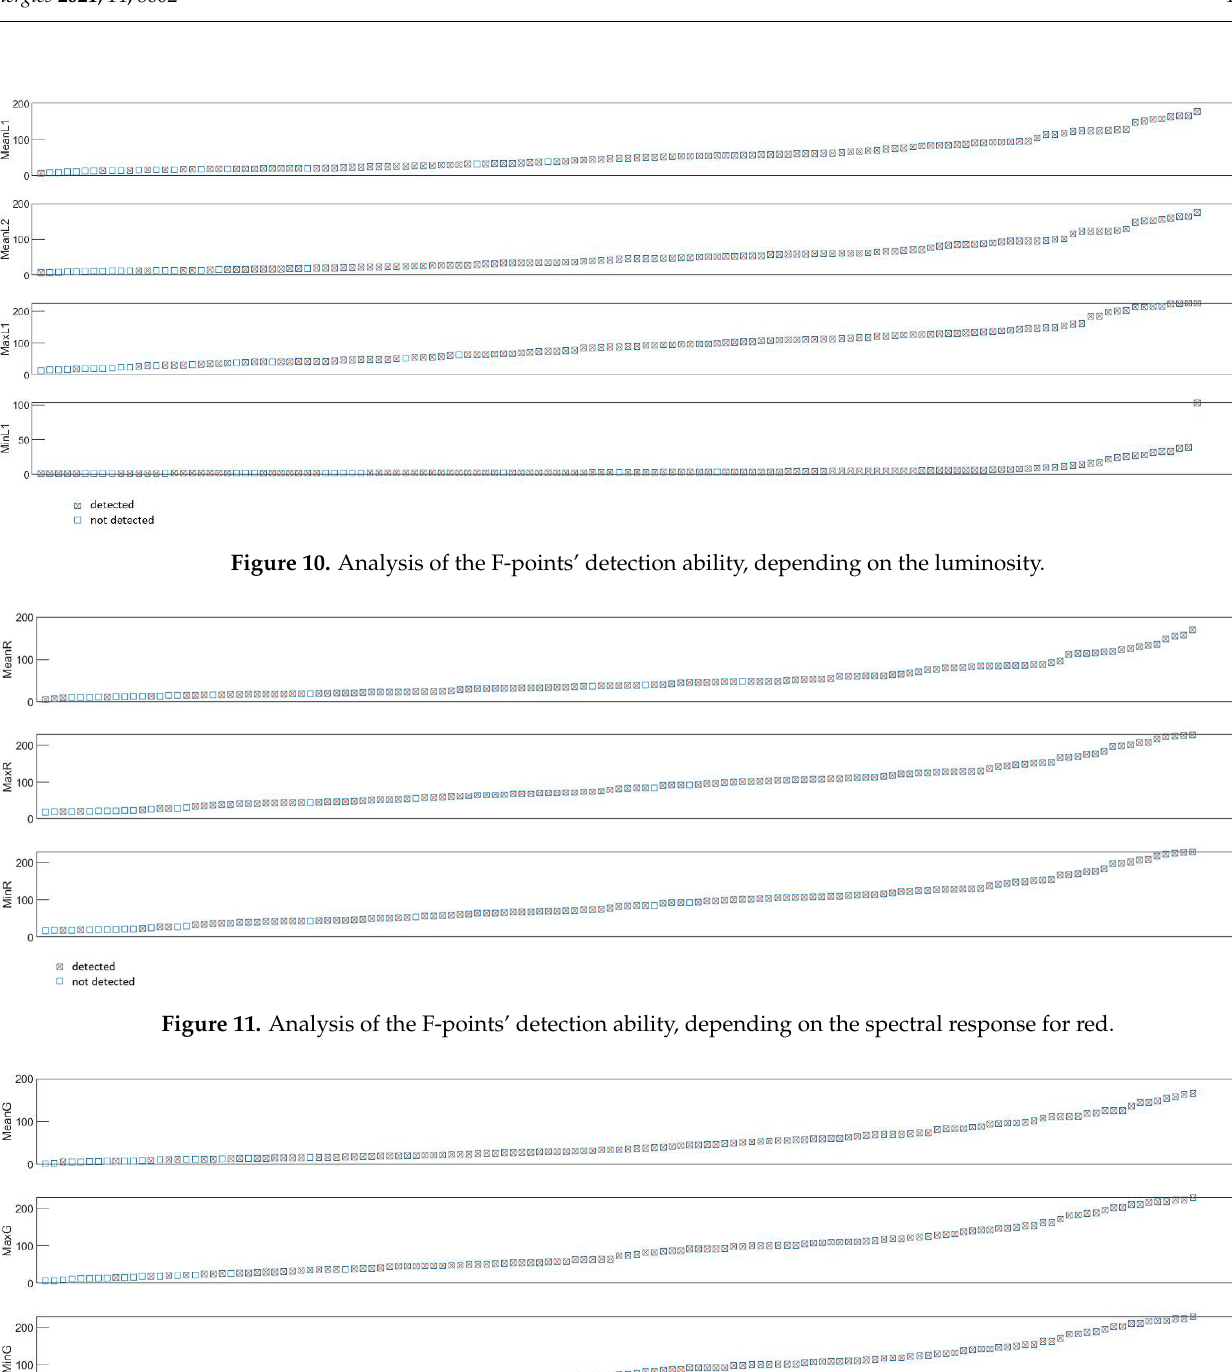
Figure 11. Analysis of the F-points’ detection ability, depending on the spectral response for red.